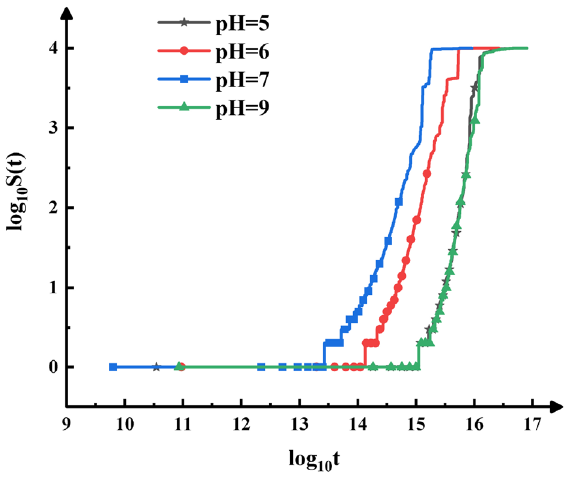
Figure 6. A log–log plot of the weighted average cluster size, S ( t ), as a function of time t , for the initial particle concentration, c , is 0.01 and different